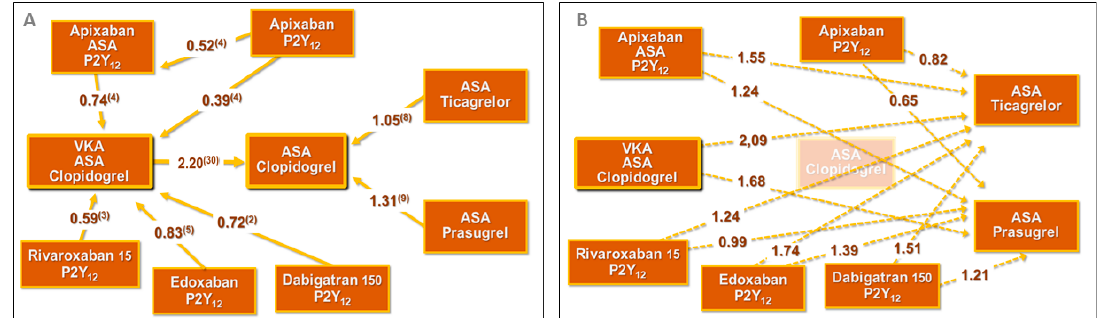
Figure 5. Bleeding hazard ratios for different antithrombotic treatments. ( A ) Direct comparisons from randomized trials or observational studies. References are reported for each hazard ratio. ( B ) Indirect network comparisons of different antithrombotic treatments.